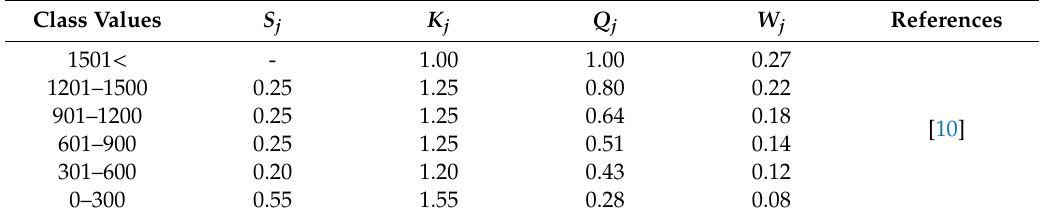
Table 4. Each class’ calculated weight of police station as an alternative using SWARA.